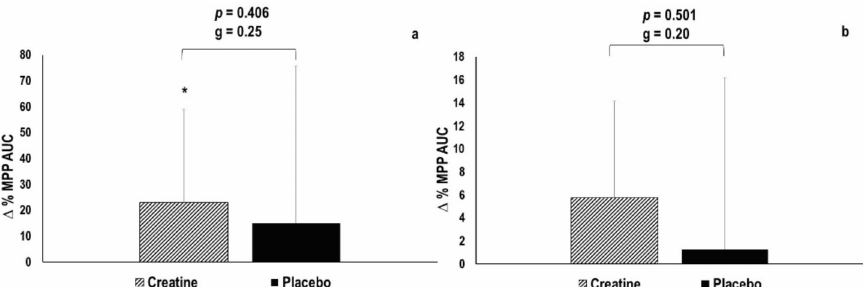
Figure 5. ( a ) Changes in total work during repetitions-to-failure test (RFT). ( b ) Changes in total work per repetitions performed in RFT. MPP = mean propulsive power; AUC = area under the curve; * Statistically significant difference between pre and post, p ≤